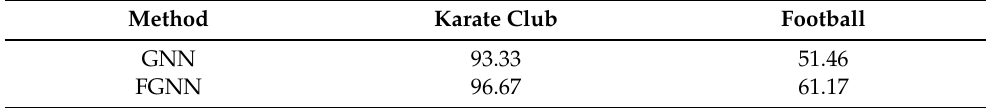
Table 7. Recognition accuracy (%) of GNN and FGNN on community network